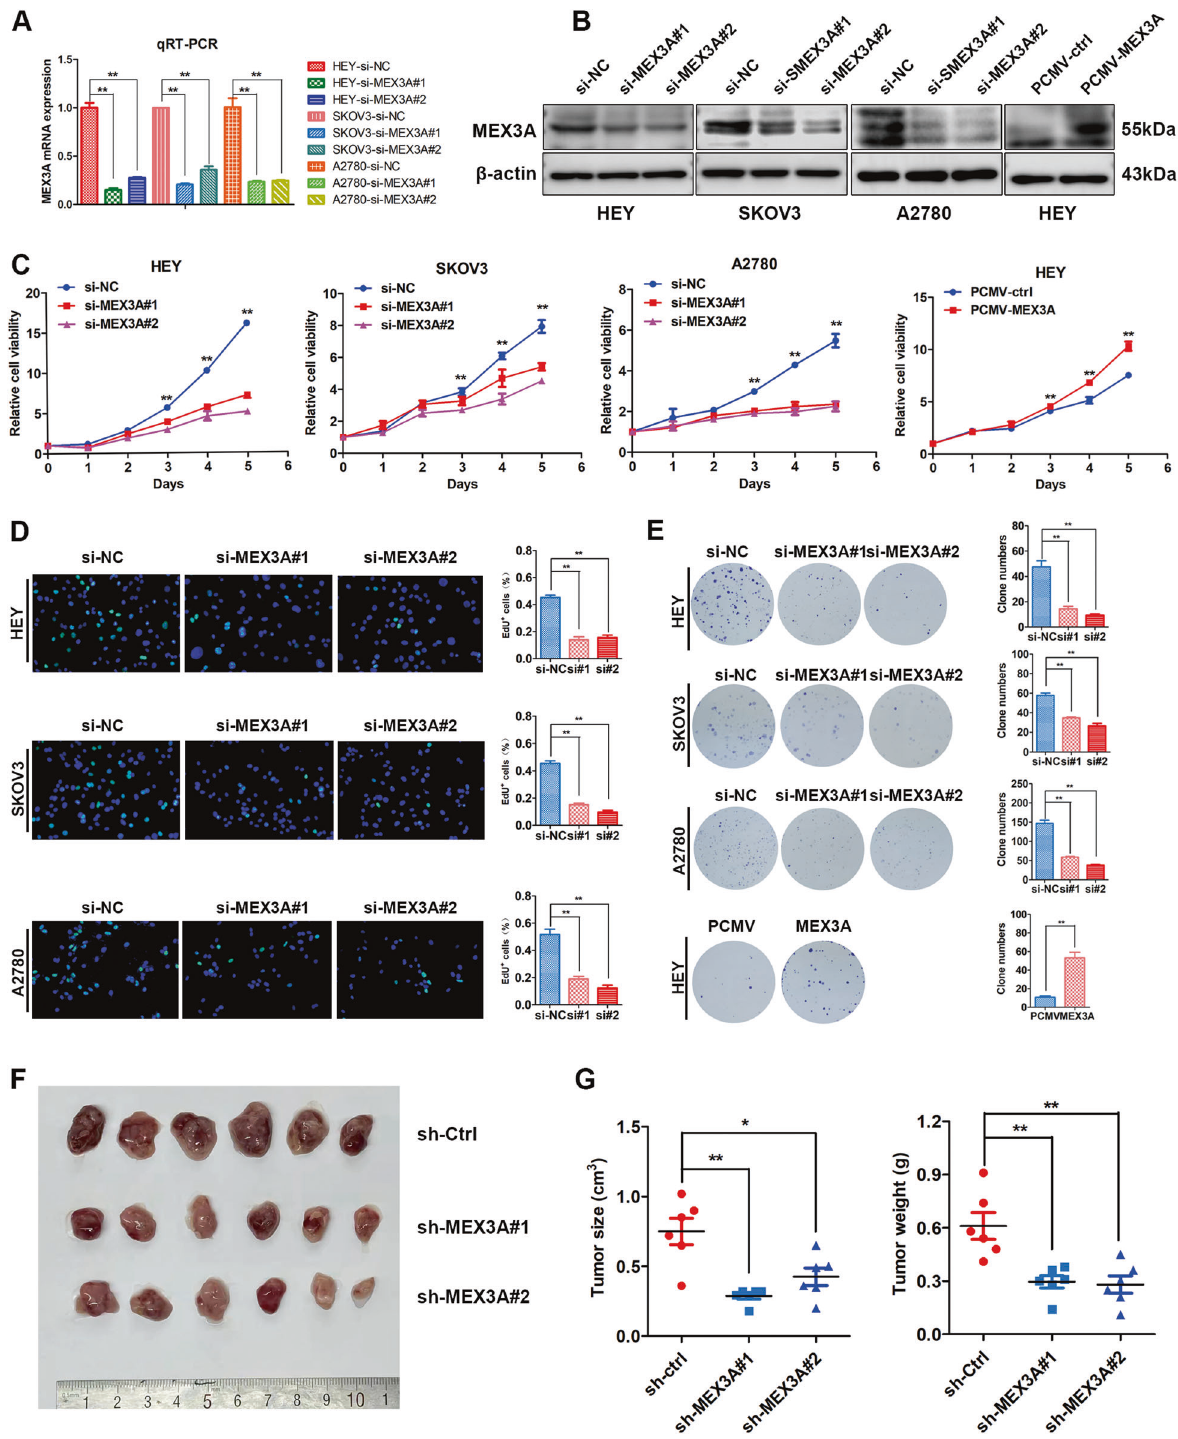
Fig. 2 MEX3A knockdown inhibits the cell proliferation and tumor growth of ovarian cancer cells in vitro and in vivo. A , B MEX3A knockdown and overexpression ef fi ciency were con fi rmed by qRT-PCR ( n = 4 biologically independent samples) and western blotting. C Growth curve showing the growth of ovarian cancer cells upon MEX3A knockdown or overexpression ( n = 5 biologically independent samples). D EdU assay showed the proliferation ability changes of ovarian cancer cells after MEX3A knockdown ( n = 5 biologically independent samples). E The clonogenic assay showed the clonogenic capacity changes of ovarian cancer cells after MEX3A knockdown and overexpression ( n = 5 biologically independent samples). F Images of tumors isolated from subcutaneous implantation of nude mice with MEX3A knockdown and control cells ( n = 6 mice per group). G Tumor size and weight statistics. P -value was obtained by unpaired t -test. Results represent the mean ± SD of three independent experiments. * P < 0.05, ** P < 0.01.